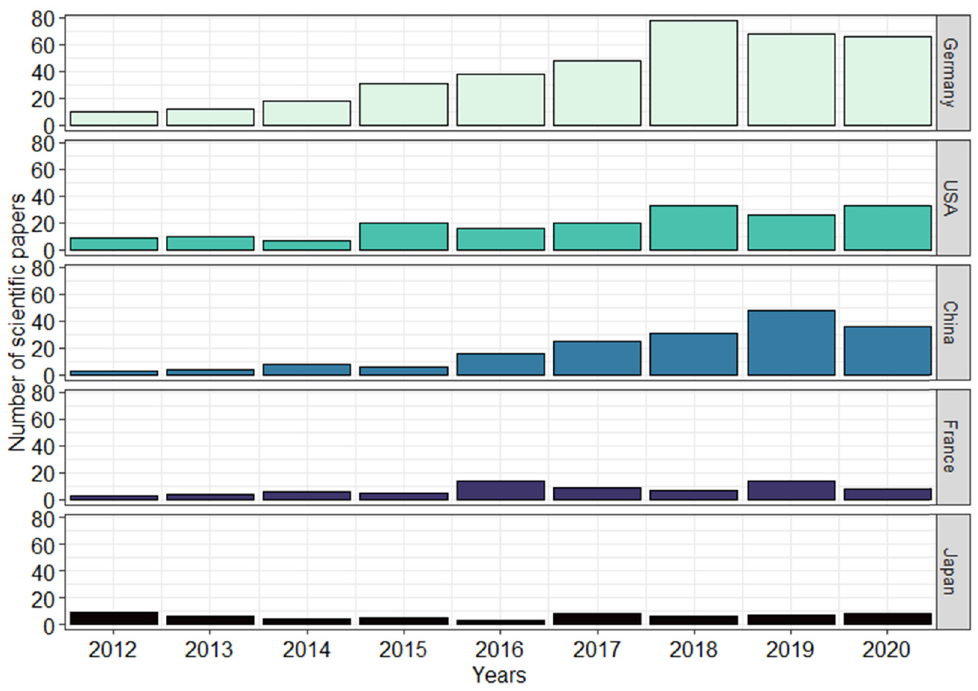
Figure 5: Publications of the top fi ve countries in collaboration with Russia from 2012 to 2020. Source: Own calculation using R software 4.0.2 ( 2021 ) based on the data aggregated by the Clarivate Analytics, WoS Core Collection ( 2021 ) .